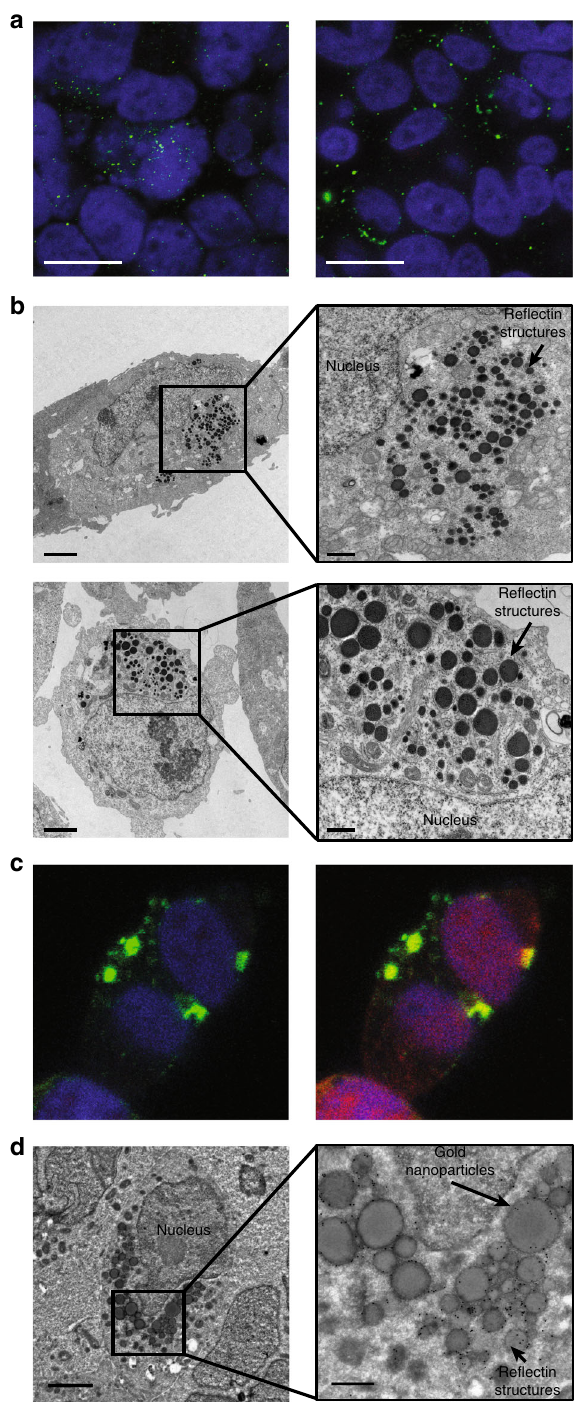
Fig. 2 Con fi rmation of the formation of squid protein-based architectures in human cells. a (Left) Merged fl uorescence microscopy images of fi xed RfA1-expressing cells stained with DAPI and labeled with an antibody pair speci fi c for the protein ’ s histidine-tag. (Right) Merged fl uorescence microscopy images of fi xed RfA1-expressing cells stained with DAPI and labeled with an antibody pair speci fi c for re fl ectins ’ unique sequence. The signals corresponding to DAPI and the Alexa 488 fl uorophore- conjugated secondary antibody are colored blue and green, respectively, in both images. The scale bars are 15 µ m in both images. b (Top) A TEM image of a cross-section from one representative RfA1-expressing cell, which reveals the presence of electron-dense structures. The scale bar is 2 µ m. The inset shows a close-up image of a nanoparticle cluster. The scale bar is 500 nm for the inset. (Bottom) A TEM image of a cross-section from another representative RfA1-expressing cell, which also reveals the presence of electron-dense structures. The scale bar is 2 µ m. The inset shows a close-up image of a nanoparticle cluster. The scale bar is 500 nm for the inset. c Merged fl uorescence microscopy images of fi xed RfA1- and RFP-expressing cells stained with DAPI and labeled with an antibody pair speci fi c for re fl ectins ’ unique sequence. (Left) The signals corresponding to DAPI and the Alexa 488 fl uorophore-conjugated secondary antibody are shown, and they are colored blue and green, respectively. (Right) The signals corresponding to DAPI, the Alexa 488 fl uorophore-conjugated secondary antibody, and RFP are shown, and they are colored blue, green, and red, respectively. The scale bars are 10 µ m in both images. d (Left) An immuno-EM image of a cross-section from a representative cell, which has been labeled with a primary antibody speci fi c for re fl ectins ’ unique sequence followed by a complementary secondary antibody conjugated to a gold nanoparticle. The scale bar is 2 µ m. (Right) A close-up image of a small cluster of RfA1 structures (large gray spheres), which are speci fi cally labeled by antibody-conjugated gold nanoparticles (small black dots). The scale bar is 500 nm for the